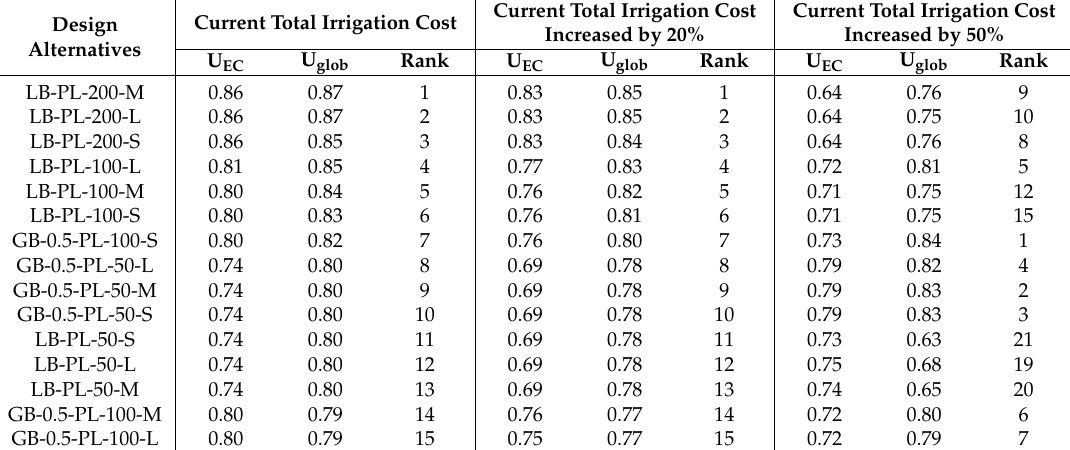
Table 12. Impacts of increasing the total irrigation cost on the ranking of design alternatives determined by the global utilities U glob considering an application to medium infiltration